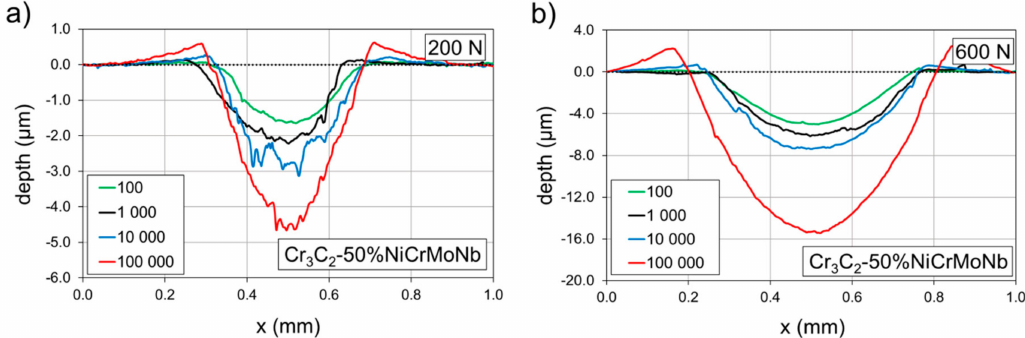
Figure 8. Profiles of the impact craters of the Cr 3 C 2 -50%NiCrMoNb coating. Comparison of the impact loads of ( a ) 200 N and ( b ) 600